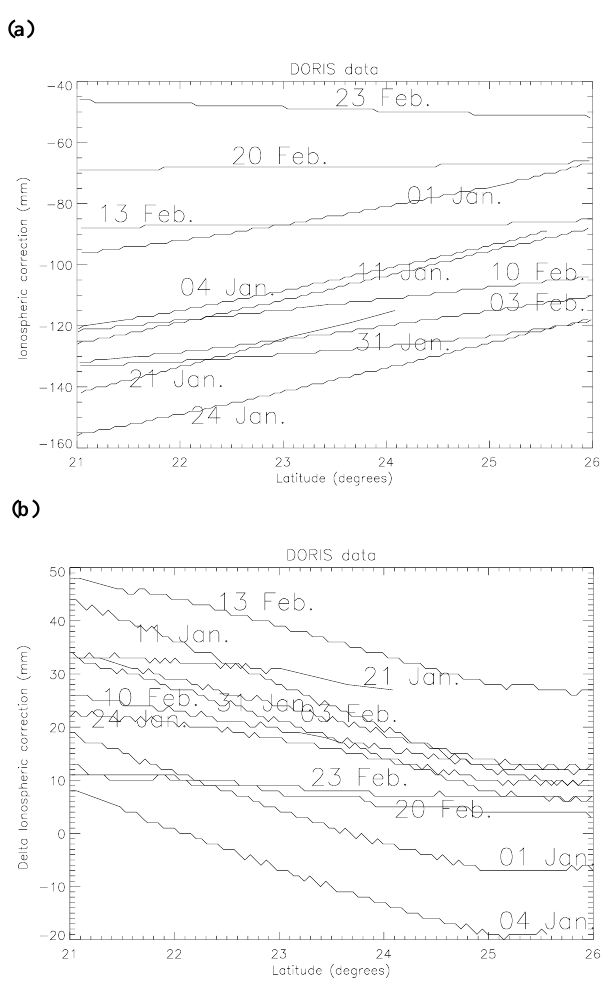
Fig. 3. Daytime variations observed by TOPEX-POSEIDON, (a) values of the ionospheric corrections as function of the latitude (see also Table 1), (b) differences between the ionospheric corrections and the Bent model as a function of the latitude.